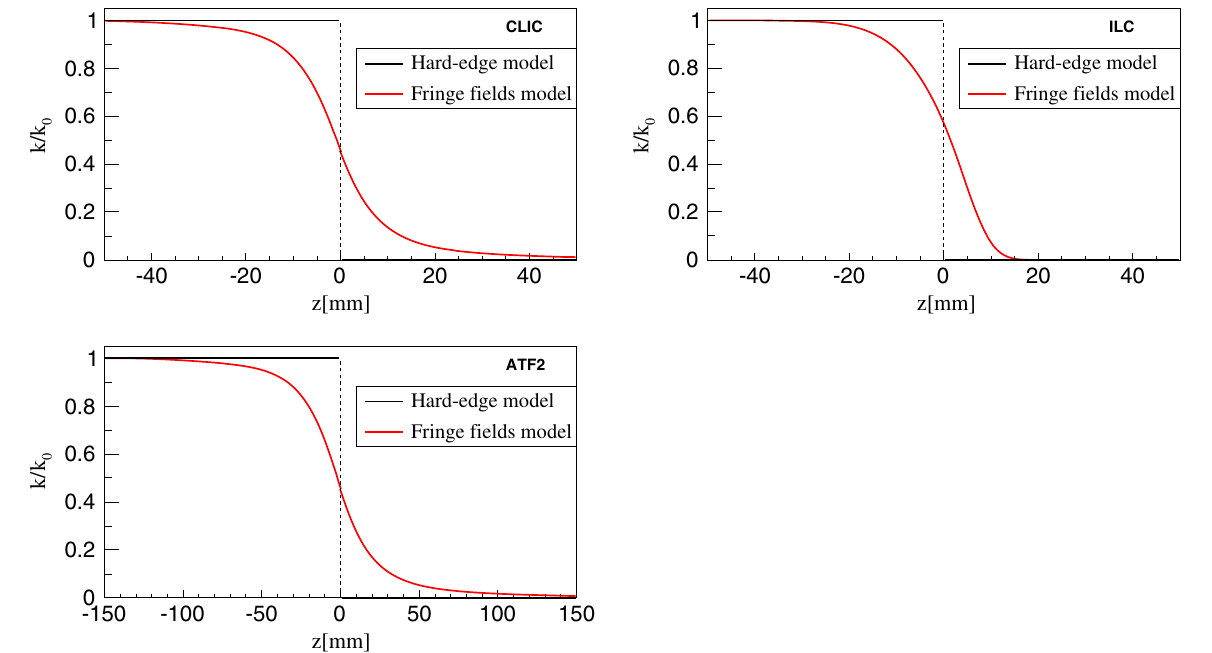
FIG. 1. Hard-edge and fringe fields models. Note the different longitudinal scale for each case, which depends on the aperture.